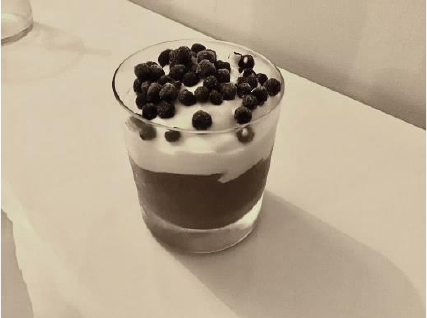
Figure 3. Dessert with vegan chocolate mousse from aquafaba (photo by Joanna